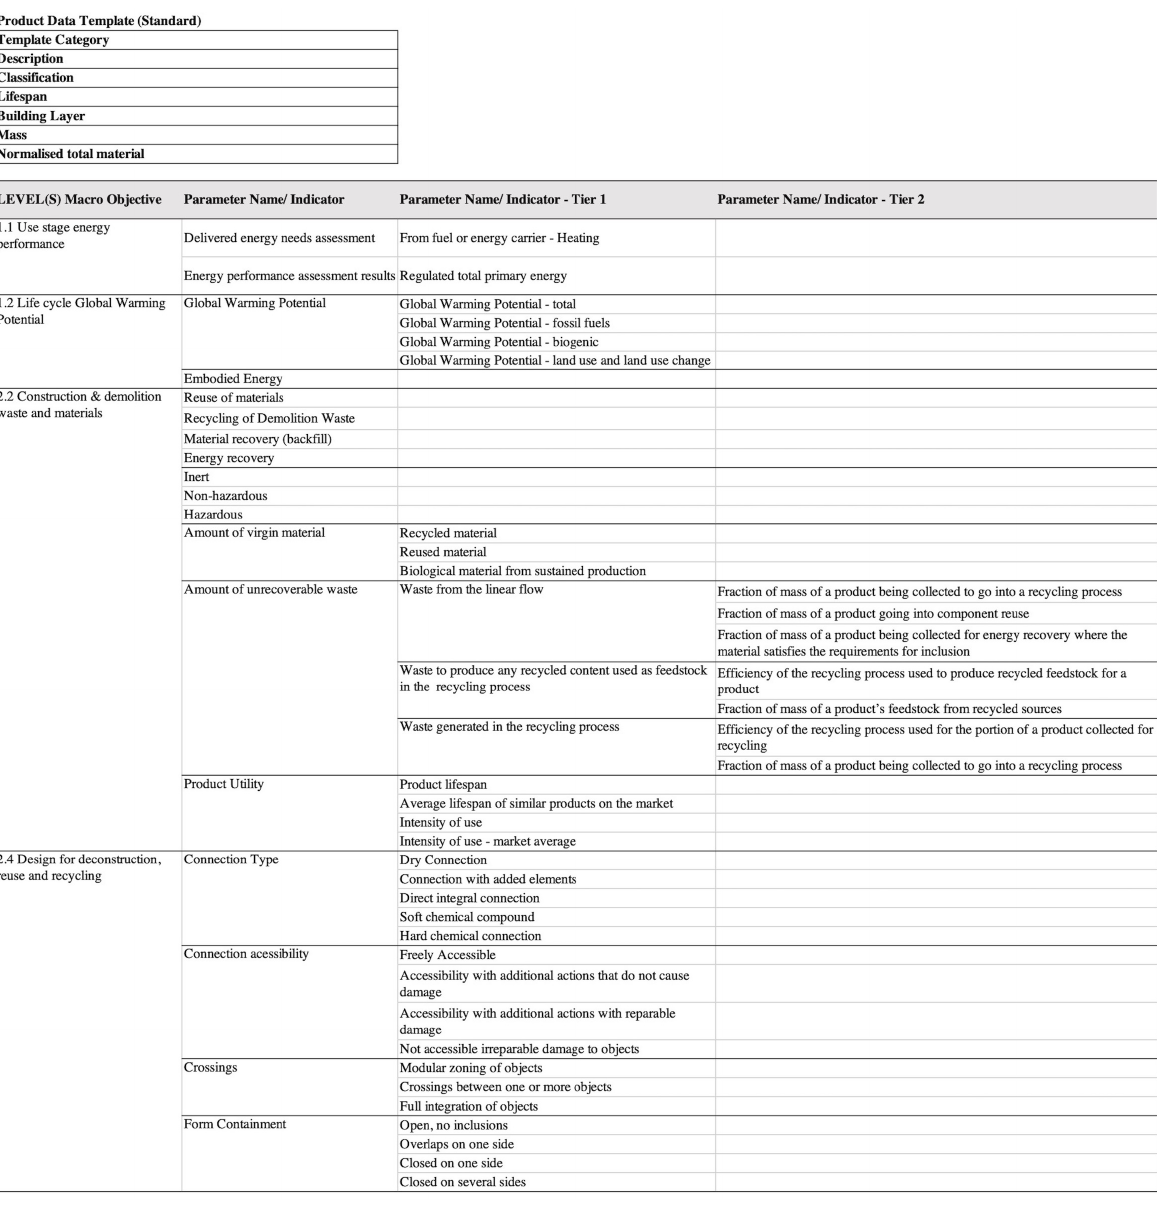
Figure 1. Product Data Template for circularity assessment.